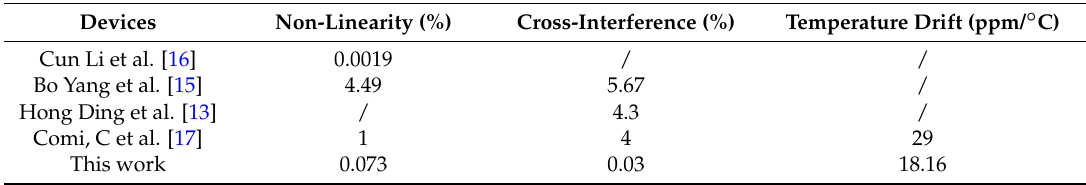
Table 3. Performance comparison with the existing